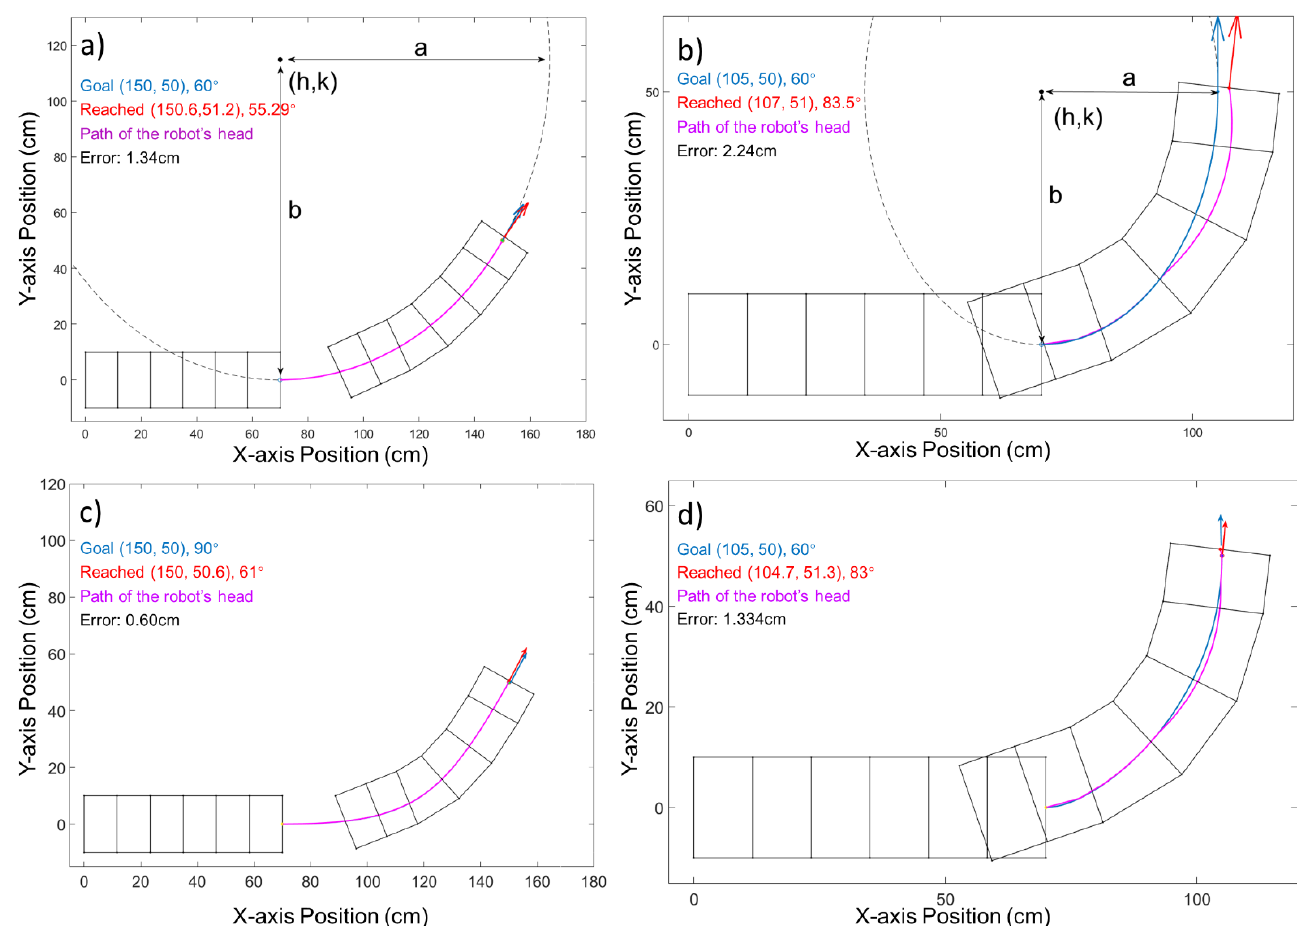
Figure 6. Comparisons between elliptical path generation and Bézier curve path; blue dot and arrow are the desired position and orientation; red dot and arrow are the simulated robot ′ s reached position. The blue curve is the generated ellipse, and pink is the executed path. ( a ) Blue and red arrows almost coincide, which shows that the robot has successfully reached its goal. ( b ) The robot fails to follow the ellipse; thus, the pink and blue curves do not coincide because the elliptical axis length in the lateral direction is too small. ( c ) The robot follows the Bézier curve and reaches the goal with a much smaller error compared to ( a ). ( d ) The robot deviates from the path but corrects the error to reach the goal.